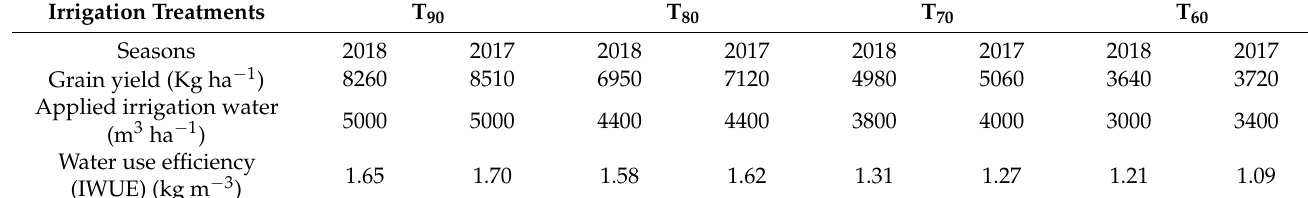
Table 8. Grain yield and irrigation water use efficiency (IWUE) for different irrigation treatments (T 90 , T 80 , T 70 , and T 60 ).